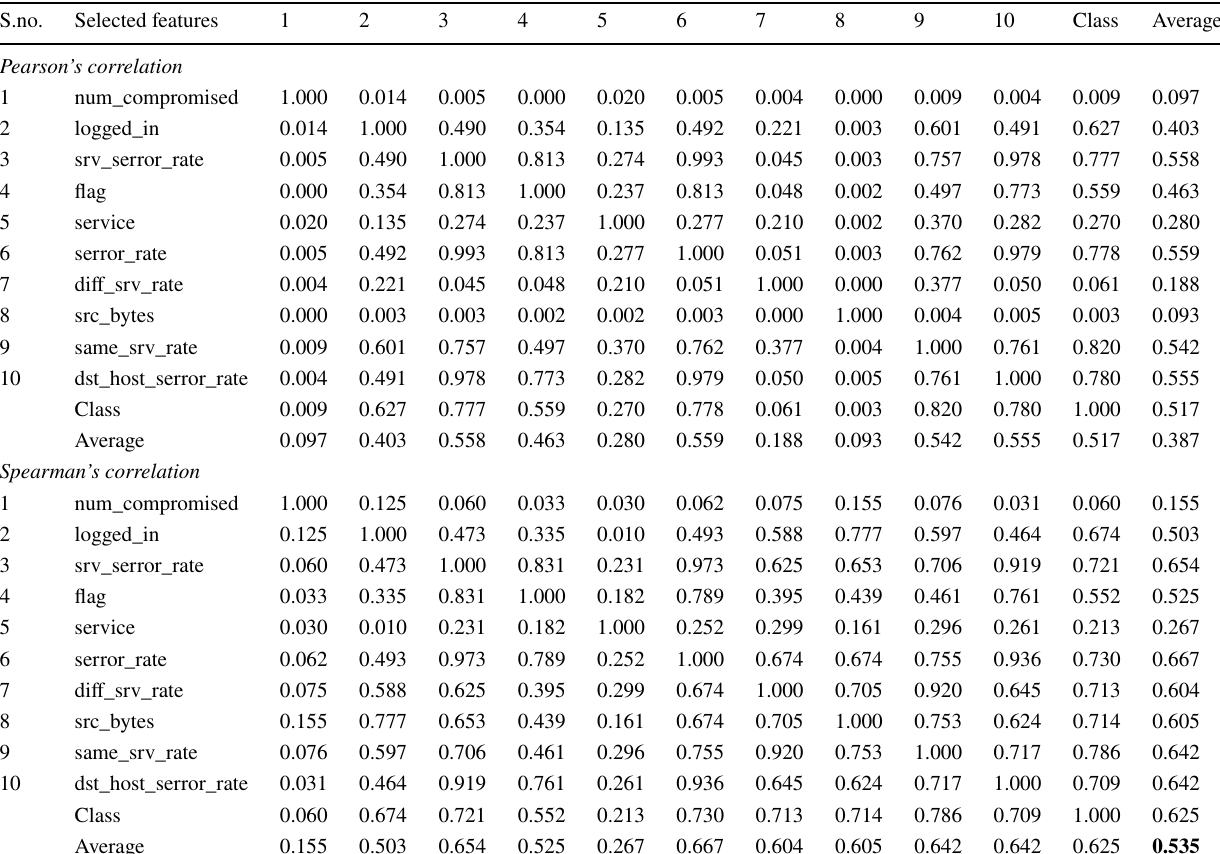
Table 8 The result of the stability test using Pearson’s ( r ) and Spearman’s ( r s ) correlation coefficient S.no.